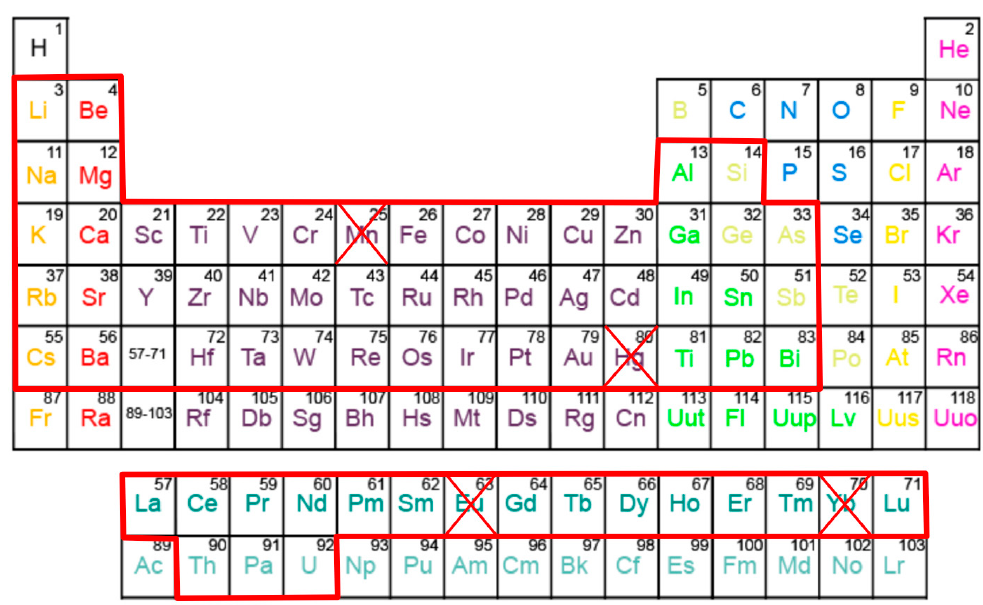
Figure 1. The elemental solids chosen for this study.